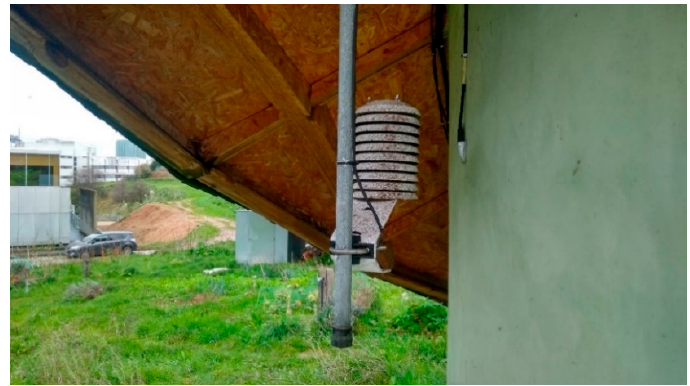
Figure 1. Location of the case study and the weather stations used. Further information of the weather stations can be found in Table 3.